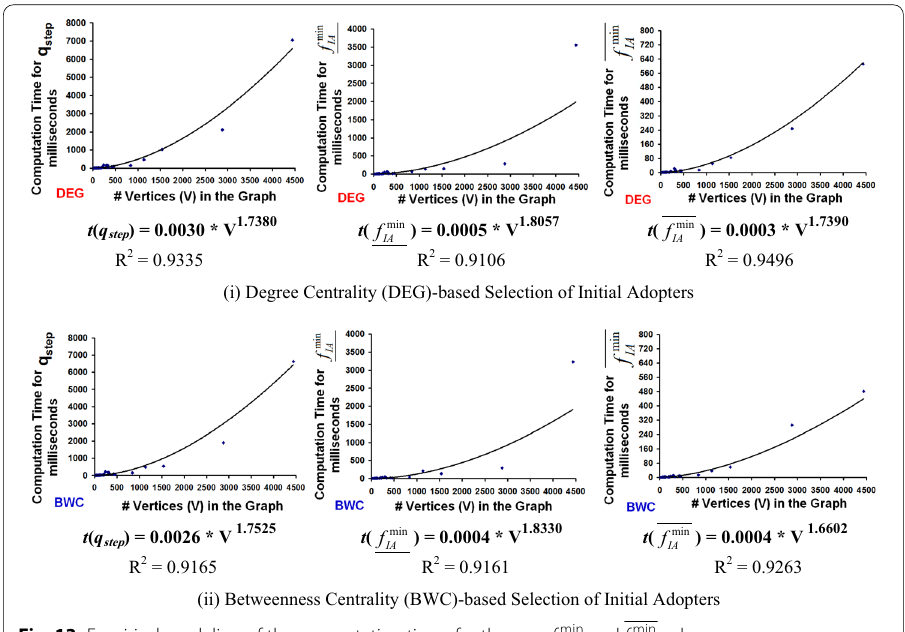
Fig. 13 Empirical modeling of the computation times for the q step , f min IA and f min IA